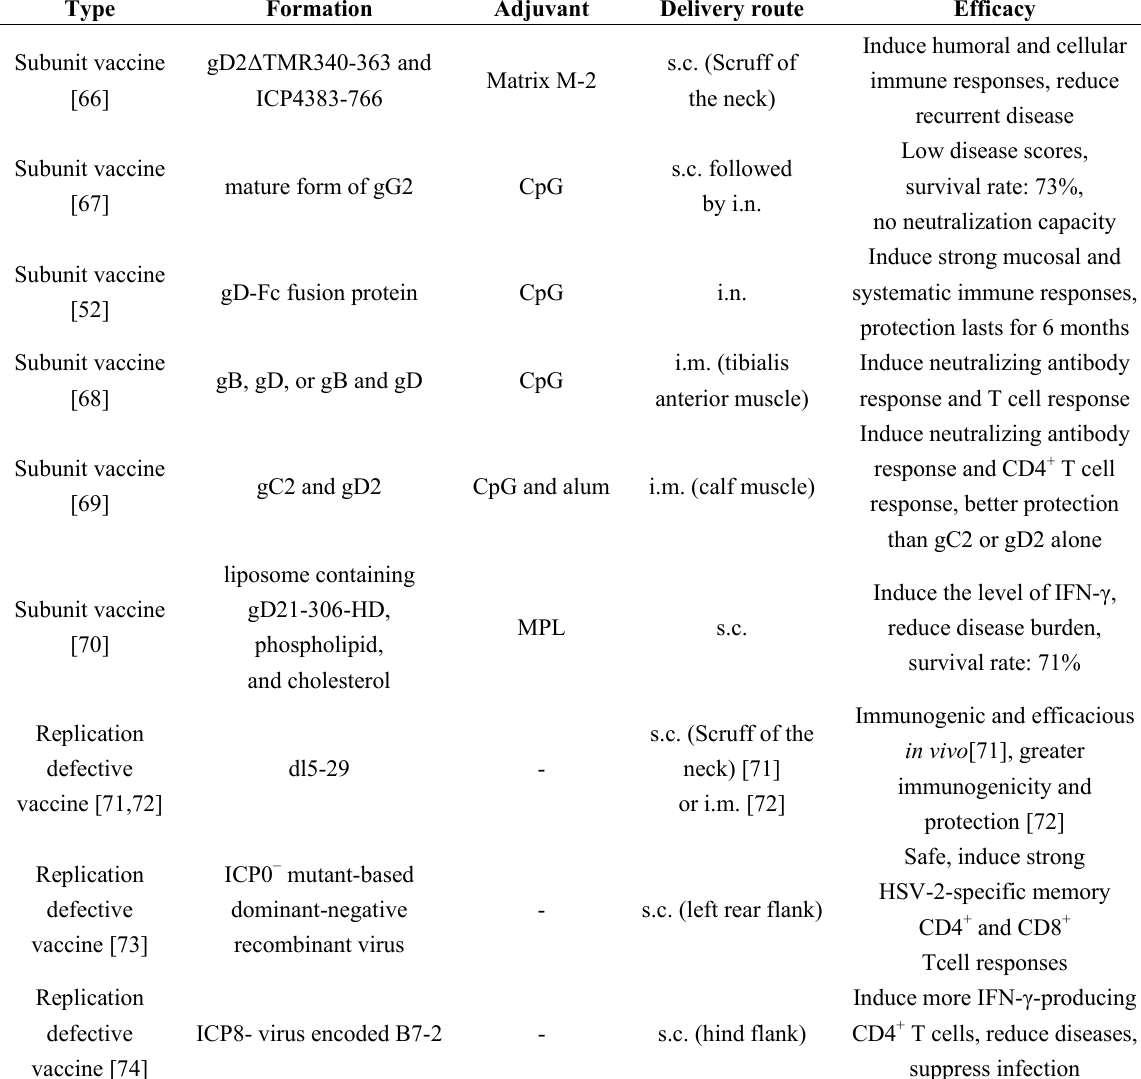
Table 1. The most promising HSV-2 vaccines tested in animals in the last five